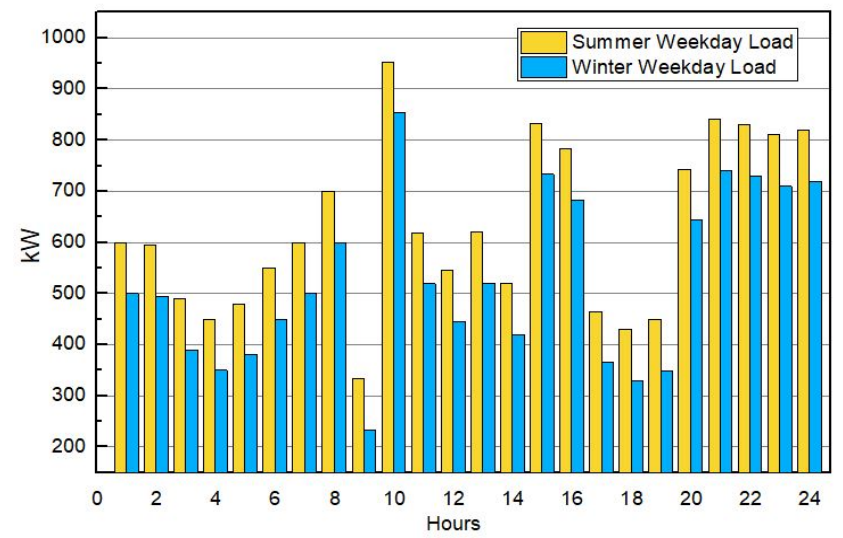
Figure 4. Campus weekdays summer and winter load behavior patterns.